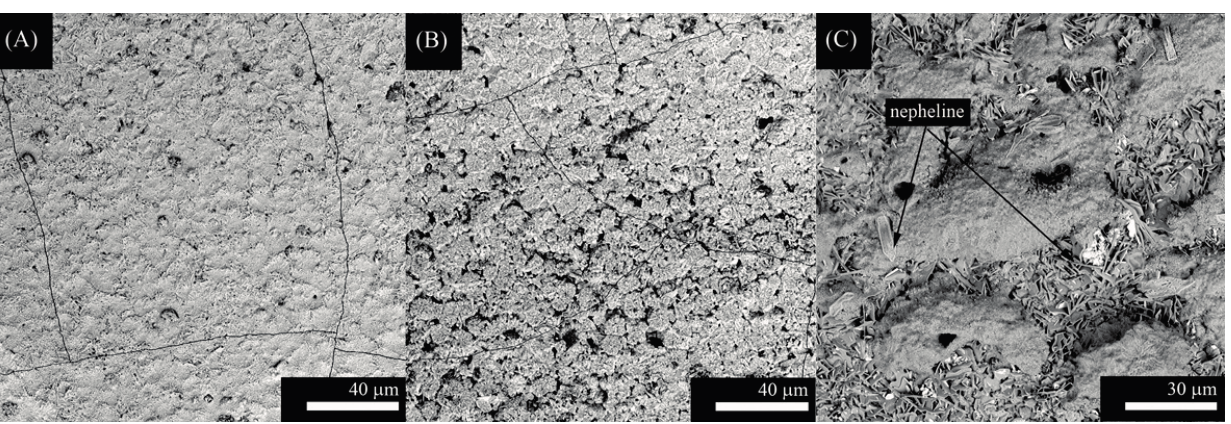
Figure 1. Scanning electronic micrographs of the top surface of the coatings with G3 on the